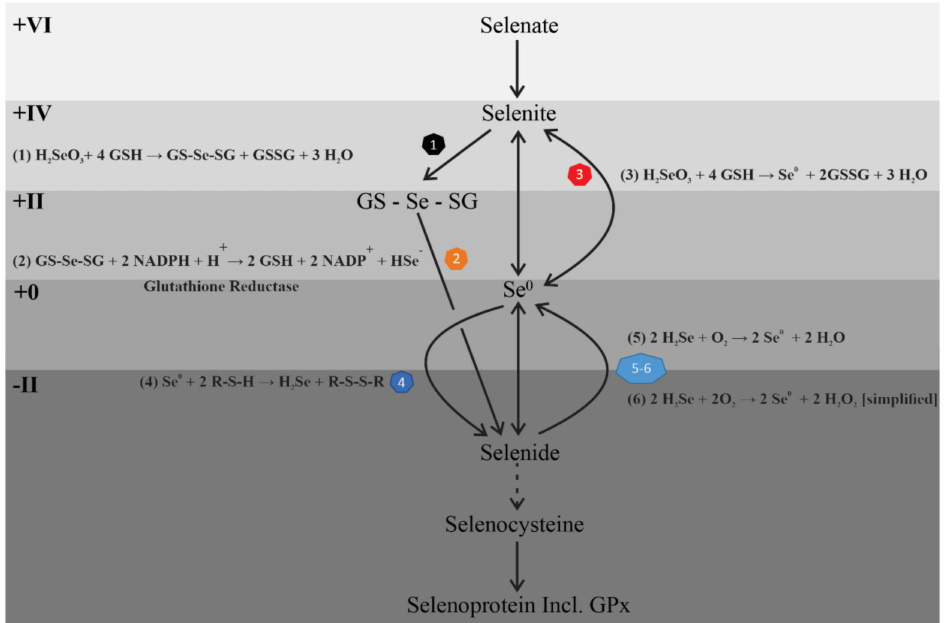
Figure 6. Pathways for formation of selenide, necessary for selenocysteine (SeCys) production, from elemental Se or selenite, and eventual incorporation into selenoproteins, including GPx. Se valencies are indicated at the left. Reaction numbers correspond to those in the text. See details in the